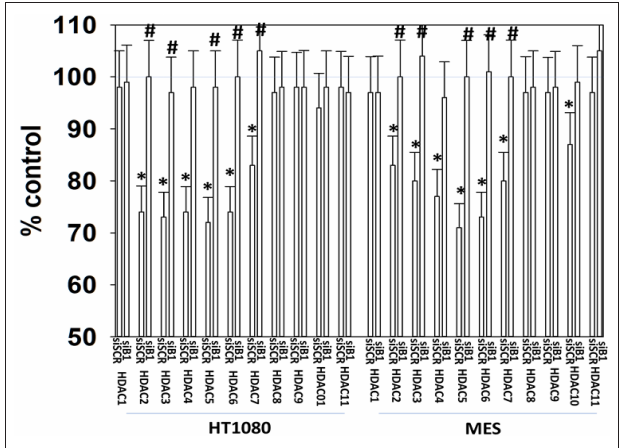
FIGURE 8 | GZ17-6.02 regulates the expression and location of HDAC proteins. HT1080 and MES human sarcoma cells were transfected with a scrambled siRNA (siSCR) or with an siRNA to knock down the expression of Beclin1. Twenty-four hour afterwards, cells treated with vehicle control or with [GZ17-6.02 (2 µ M final curcumin) for 6h. Cells were fixed in place and immunostaining performed to detect the expression of HDACs1–11 and total ERK2 ( n = 3 + /–SD). * p < 0.05 less than vehicle control; # p < 0.05 greater than vehicle control.